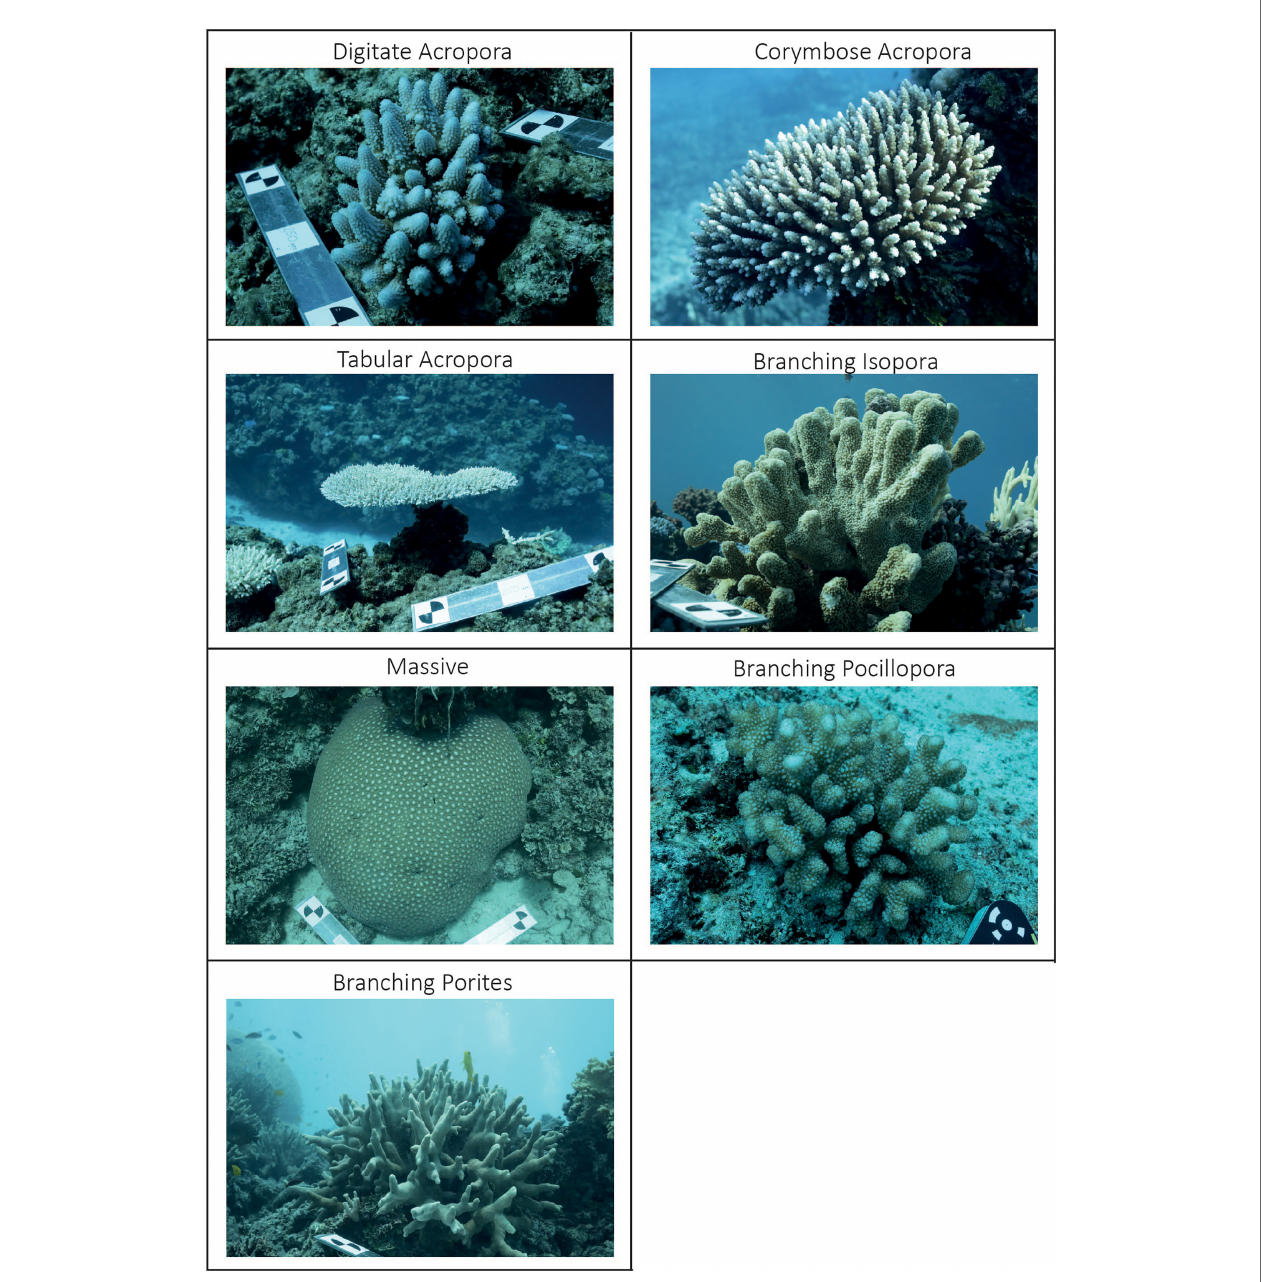
FIGURE 1 | In situ examples of the seven distinct modelled morphotaxa. Note the galvanised scale bars present in several panels used to scale the